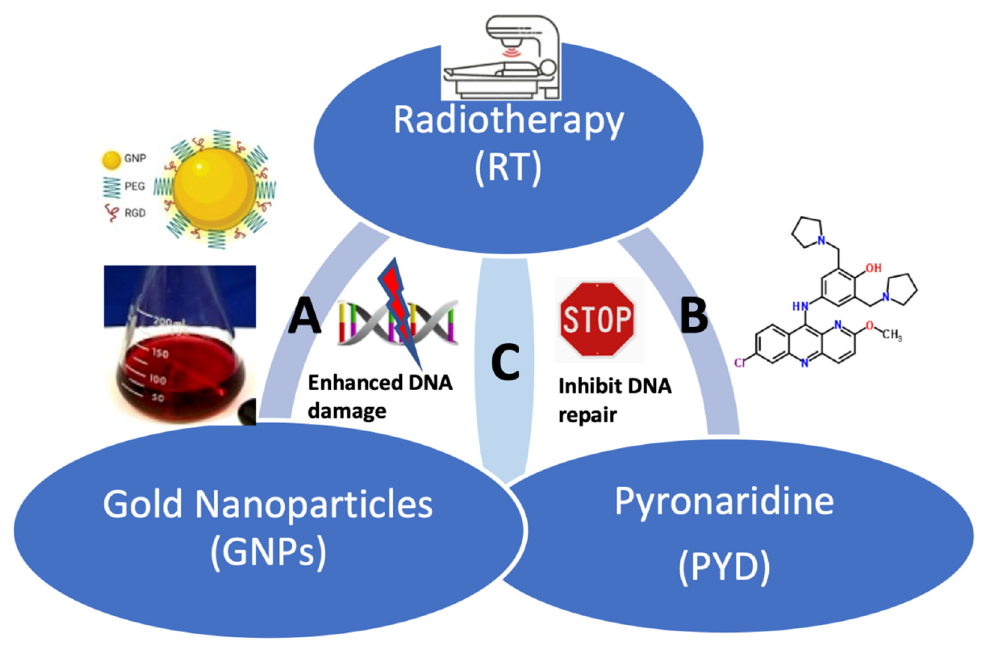
Figure 1. Combination of GNPs, RT, and PYD for a better therapeutic outcome. ( A ) Combination of GNPs with RT. ( B ) Combination of PYD with RT. ( C ) Theme of the current study: a novel combination of GNPs with PYD to further improve the therapeutic outcome in RT.